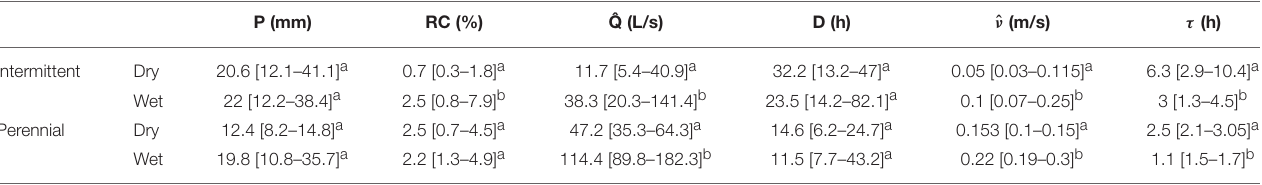
TABLE 2 | Median [25th, 75th percentiles] of precipitation ( P ), runoff coefficient ( RC ), weighted discharge ( ˆ Q ), duration ( D ), weighted velocity ( ˆ v ), and water residence time ( τ ) for individual storms at the intermittent stream (Fuirosos, n = 56) and the perennial stream (Font del Regàs, n = 27) for the dry and wet period.